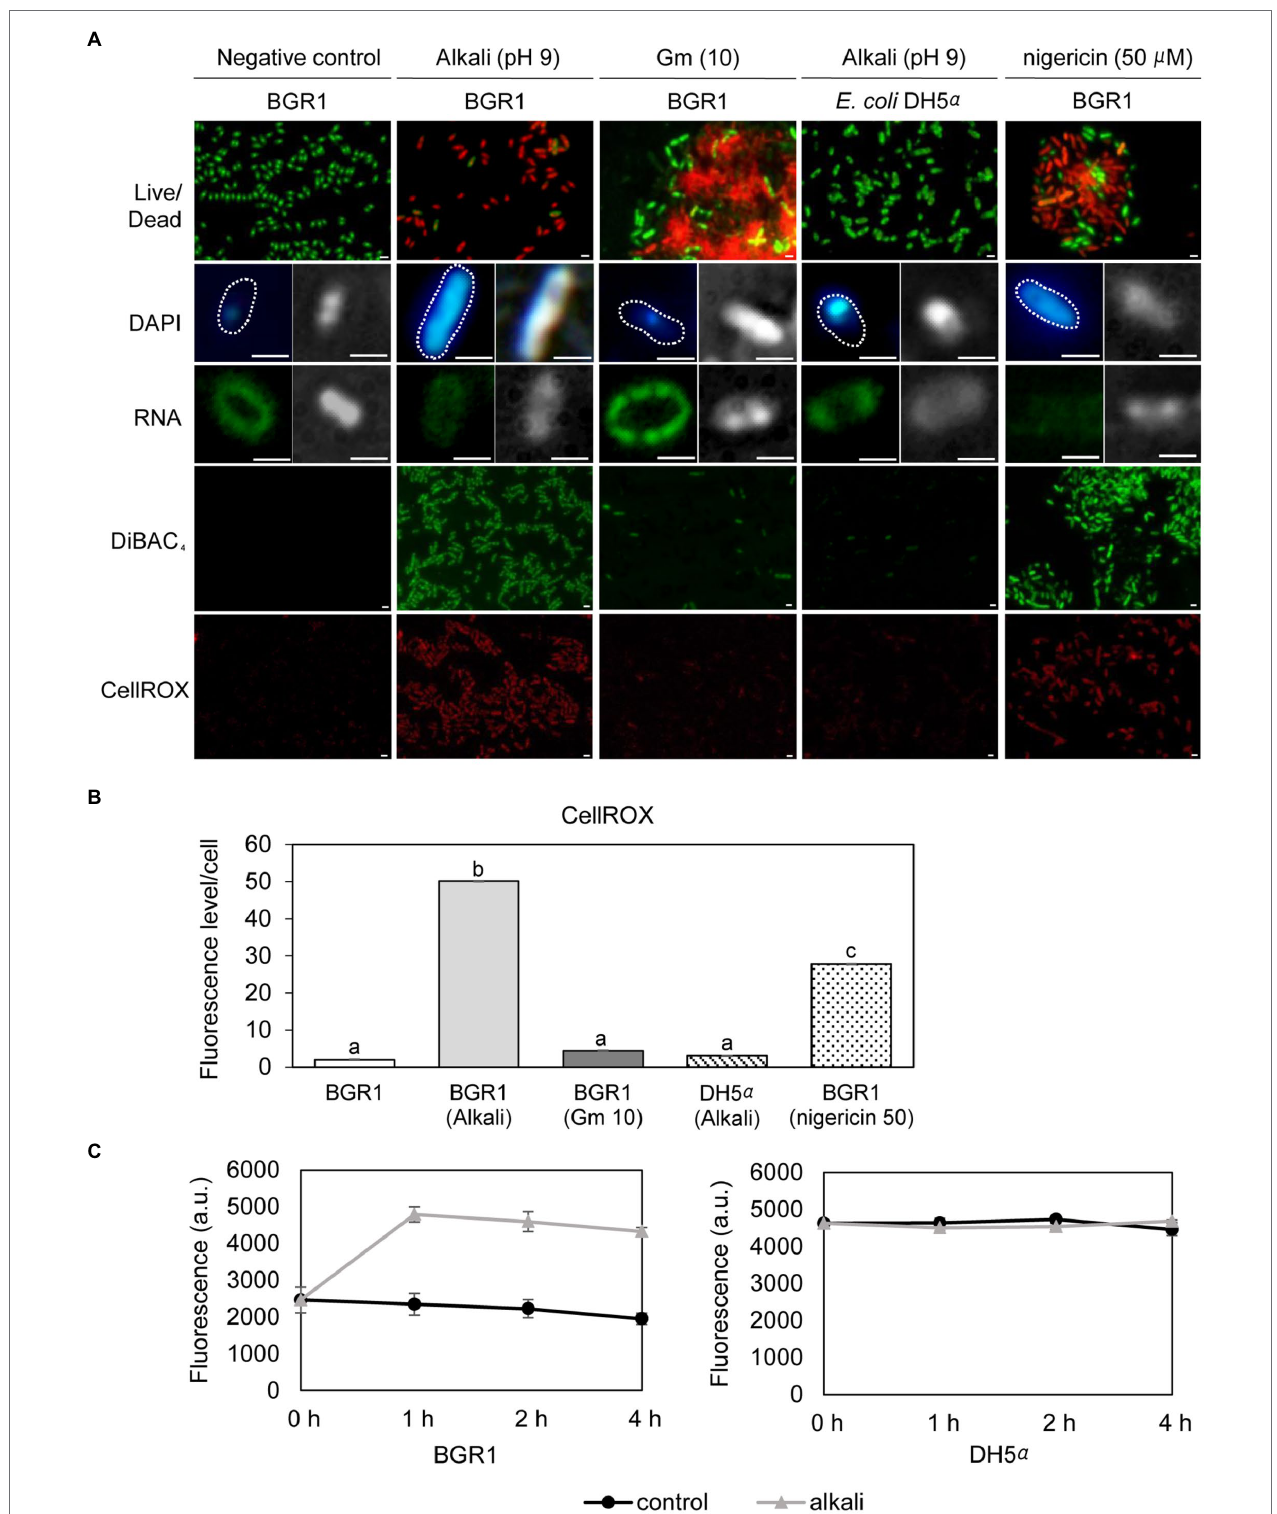
FIGURE 4 | Fluorescence staining of wild-type BGR1 and Escherichia coli DH5 α after 8 h of alkaline stress at pH 9 or antibiotic treatment with shaking at 37 ° C. (A) LIVE/DEAD, DAPI, and SYTO ™ RNASelect ™ staining were performed after 8 h of alkaline stress at pH 9. For DAPI and SYTO ™ RNASelect ™ staining, DIC microscopy (right) and merged DIC/fluorescence (left) images are depicted. Cells were stained with DiBAC 4 (3) and CellROX to observe membrane depolarization and